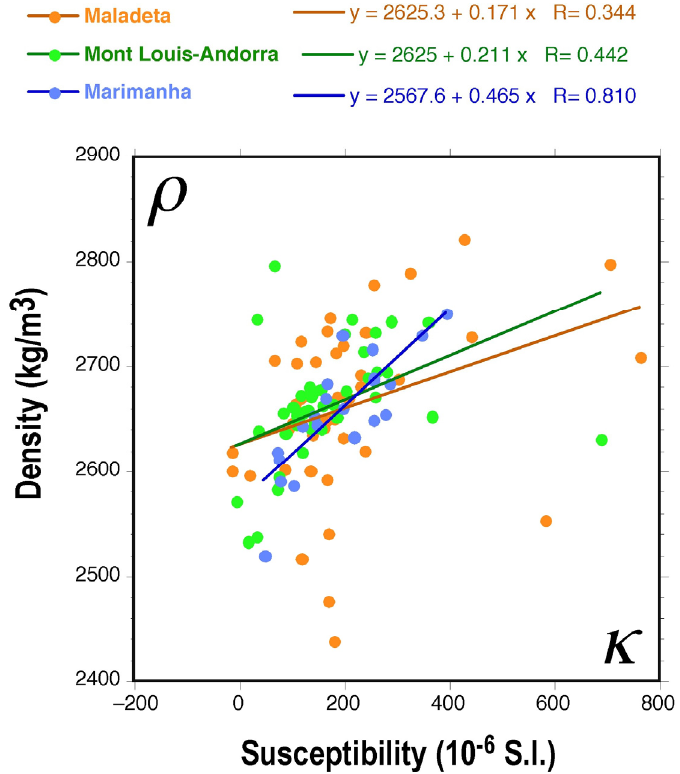
Figure 7. Density vs. magnetic susceptibility in Pyrenean granites (only data from this study are shown, see data summary in Table 3). The three studied plutons are plotted with different colors Maladeta (orange), Marimanha (blue), Mont-Louis- Andorra (green).